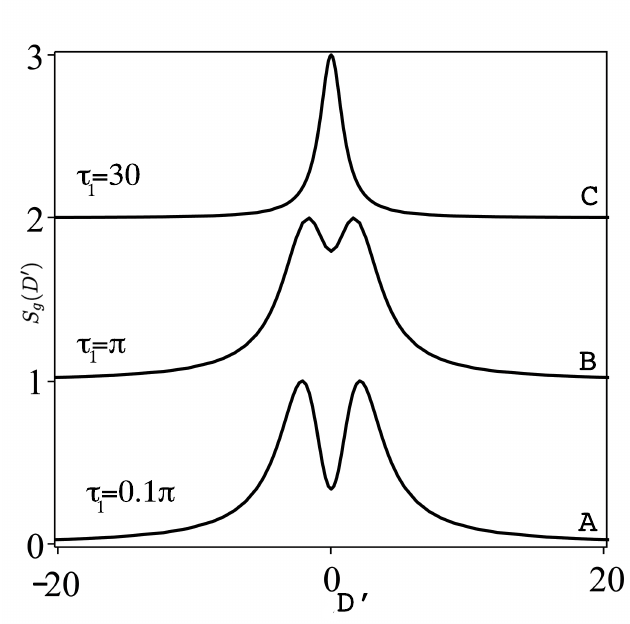
Figure 6. The normalized spectrum, S g ( D (cid:48) ) in the one pulse case ( n = 1 ) , for initial ground state, against the normalized detuning D (cid:48) with weak field, Ω 1 = 0.5 for various values of τ 1